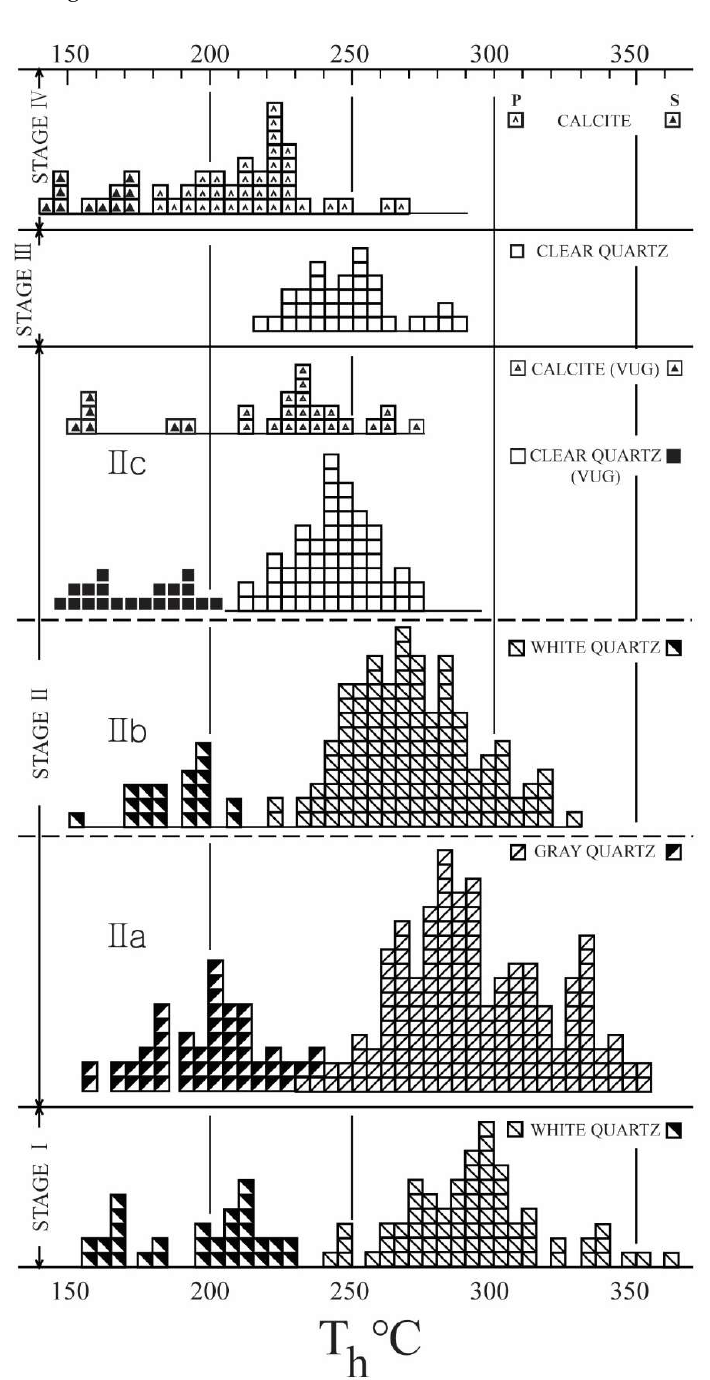
Figure 9. Homogenization temperature histograms of fluid inclusions in vein minerals from Eunjeok Au–Ag deposit. Abbreviations: P = primary, S = Secondary.